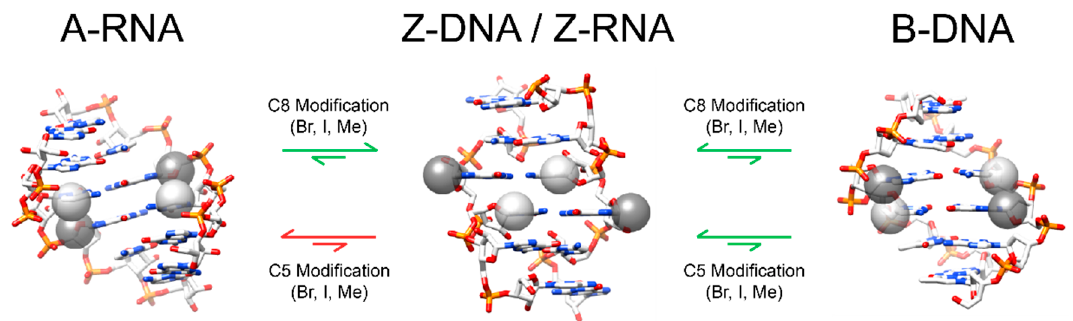
Figure 8. Chemical modifications promote or hinder Z-form adoption in nucleic acids. Structures of six-nucleotide segments of A-RNA (PDB: 4MS9 [89]), Z-RNA (PDB: 2GXB [10]), and B-DNA (PDB: 2M2C [90]) with central G•C base pairs are shown. The positions of pyrimidine C5 or purine C8 chemical modifications are modeled as light grey or dark grey spheres, respectively. In both A-RNA and B-DNA, modifications at cytidine C5 or guanosine C8 result in the chemical groups close to the phosphate with C8 often sterically clashing with phosphate groups. In the Z-conformation, C5 modifications are placed in the center of the major groove surface and C8 modifications are on the edges pointing out towards solvent. The reason for why C5 modifications hinder the A-to-Z transition is poorly understood for both methylation and halogenation.